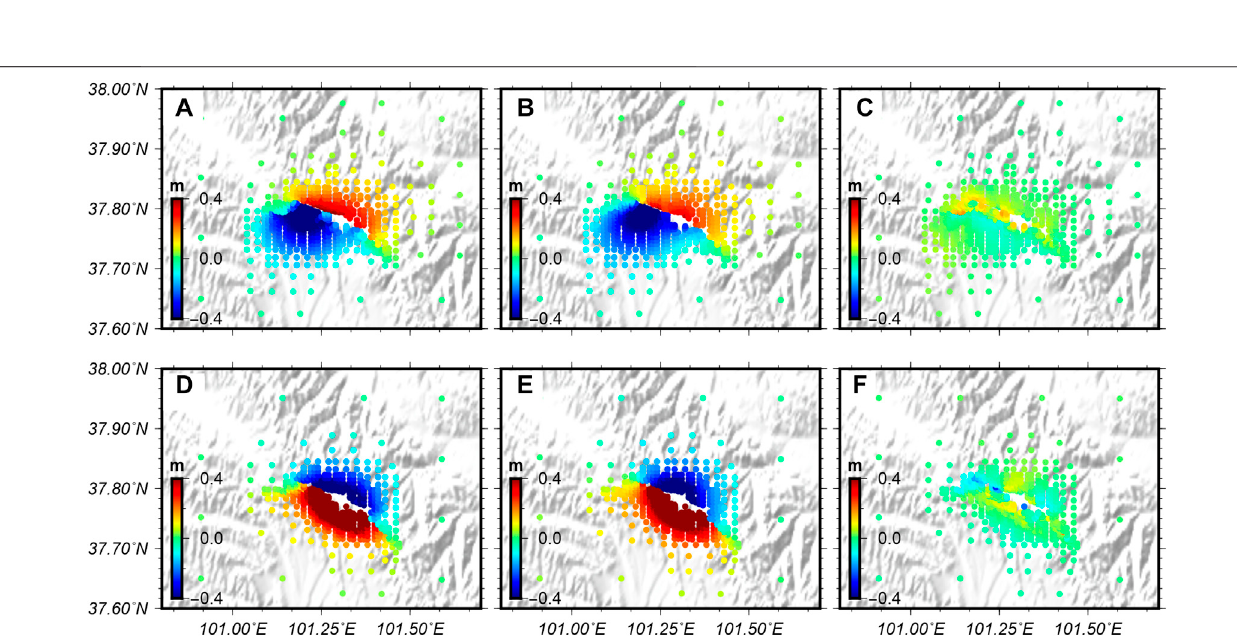
Frontiers in Earth Science |